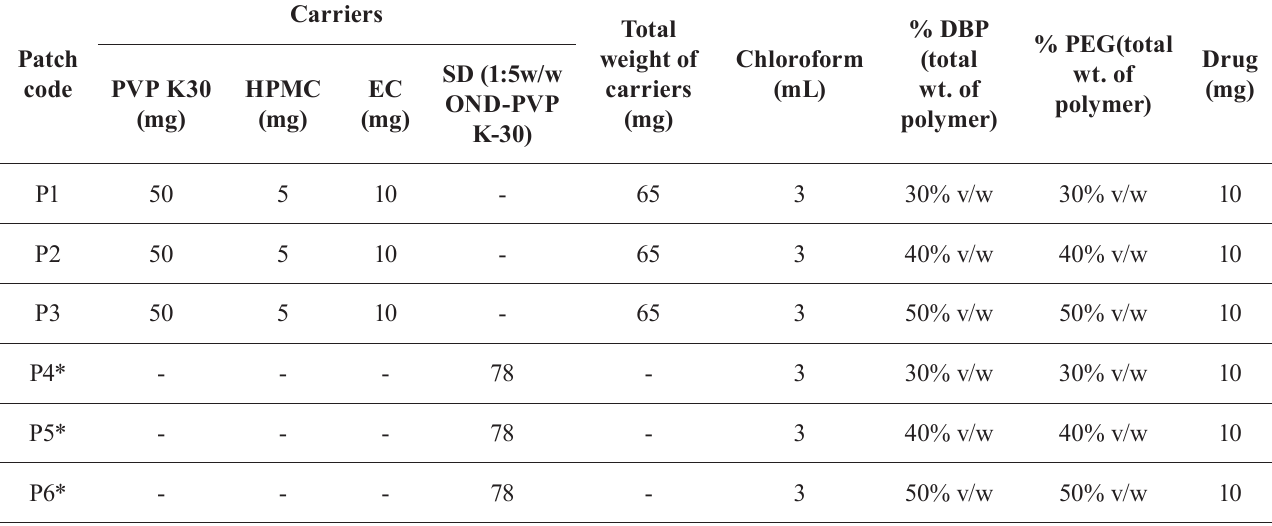
TABLE I - B atch of formulations